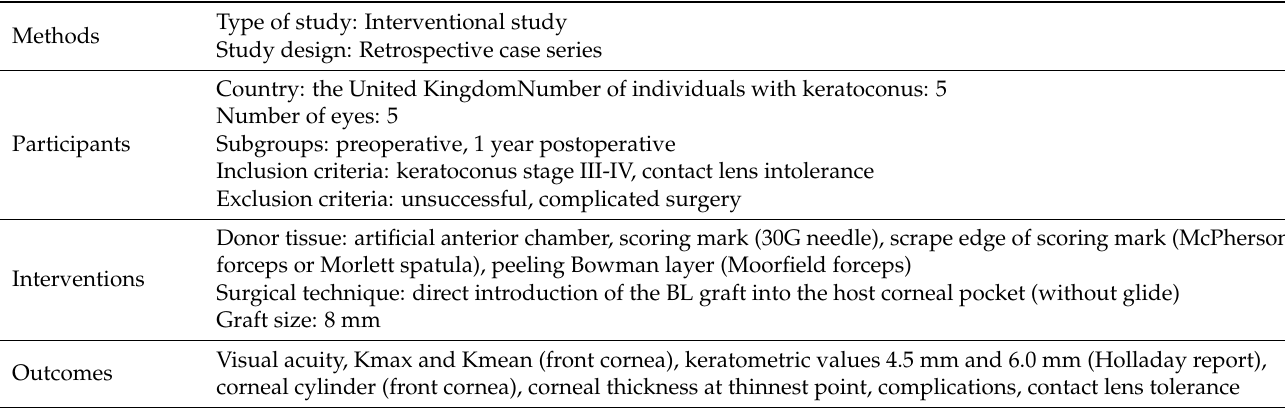
Table A10. Tourkmani 2022